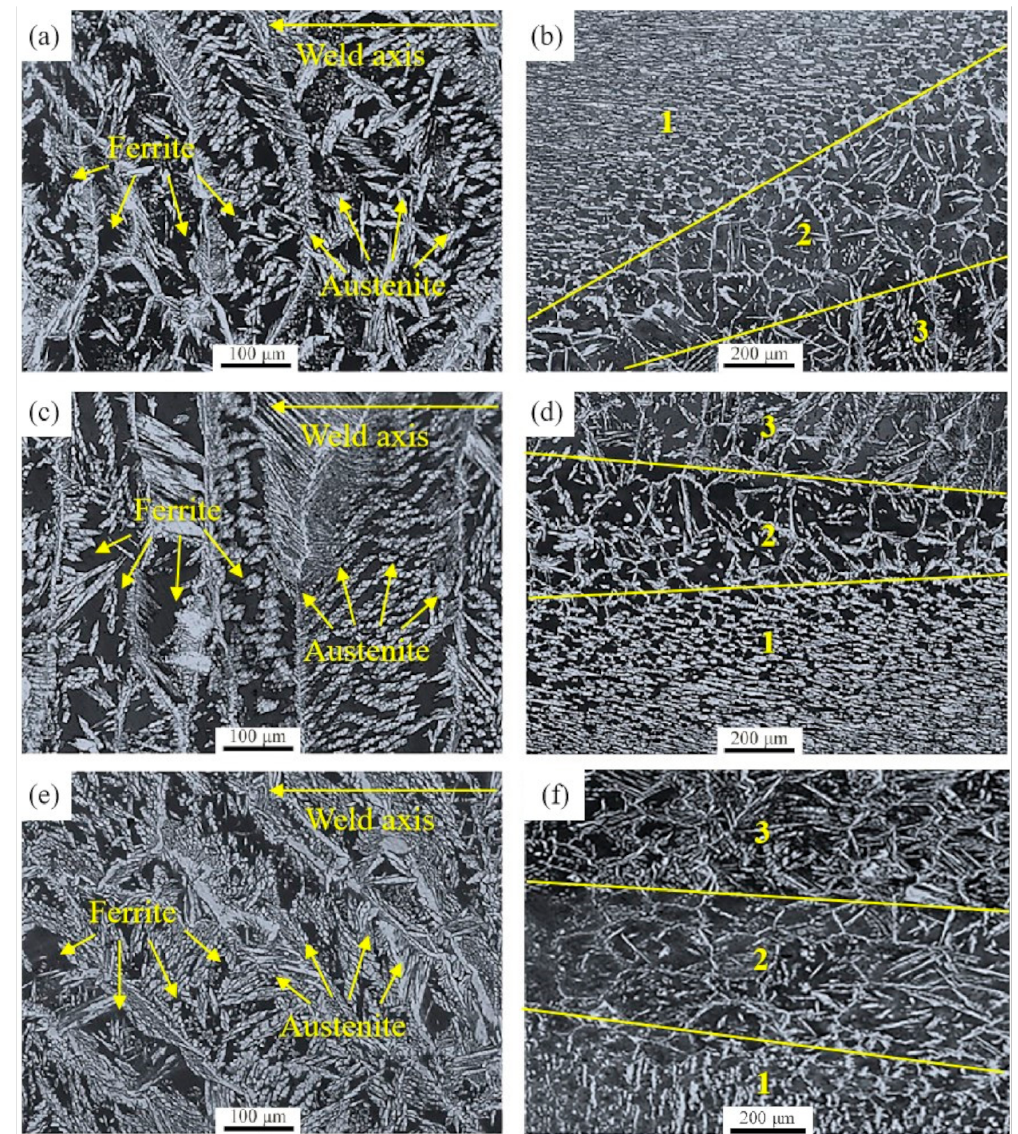
Figure 3. Metallographic structure of DSS 2205 solid wire MIG welding joints prepared in different shielding gases. ( a , b ) WS and welding joints region (pure Ar gas); ( c , d ) WS and welding joints region (98%Ar + 2%O 2 ); ( e , f ) WS and welding